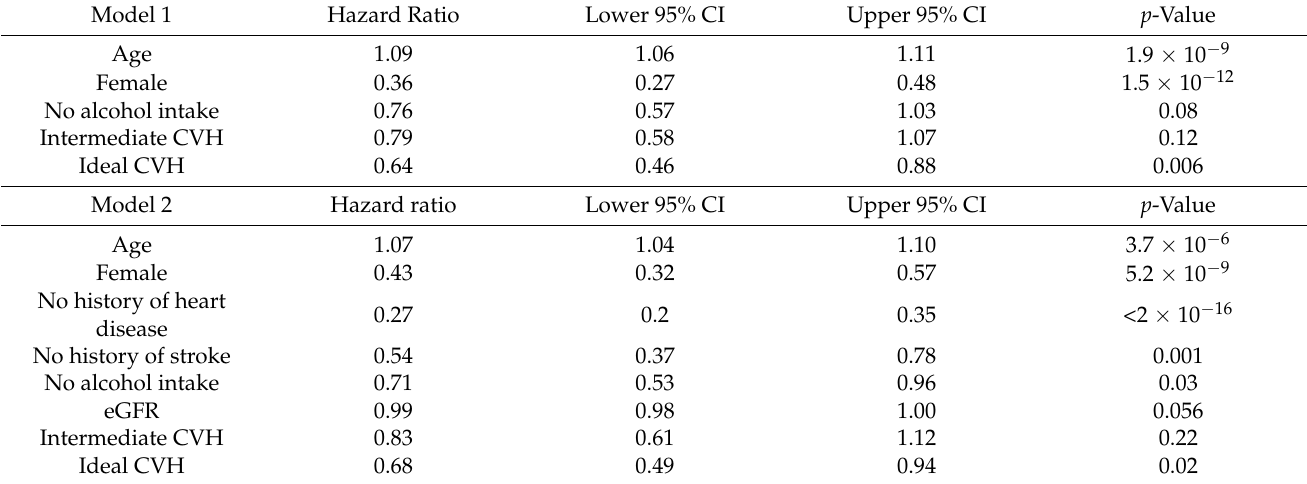
Table 3. Association between cardiovascular health (CVH) score and incident atrial fibrillation in younger participants (<75 years). Model 1 was adjusted for age, gender, and regular alcohol intake. Model 2 was adjusted for age, gender, history of heart disease, history of stroke, regular alcohol intake, and estimated glomerular filtration rate. The hazard ratio of the intermediate and ideal CVH groups was calculated using the poor CVH group as a reference.